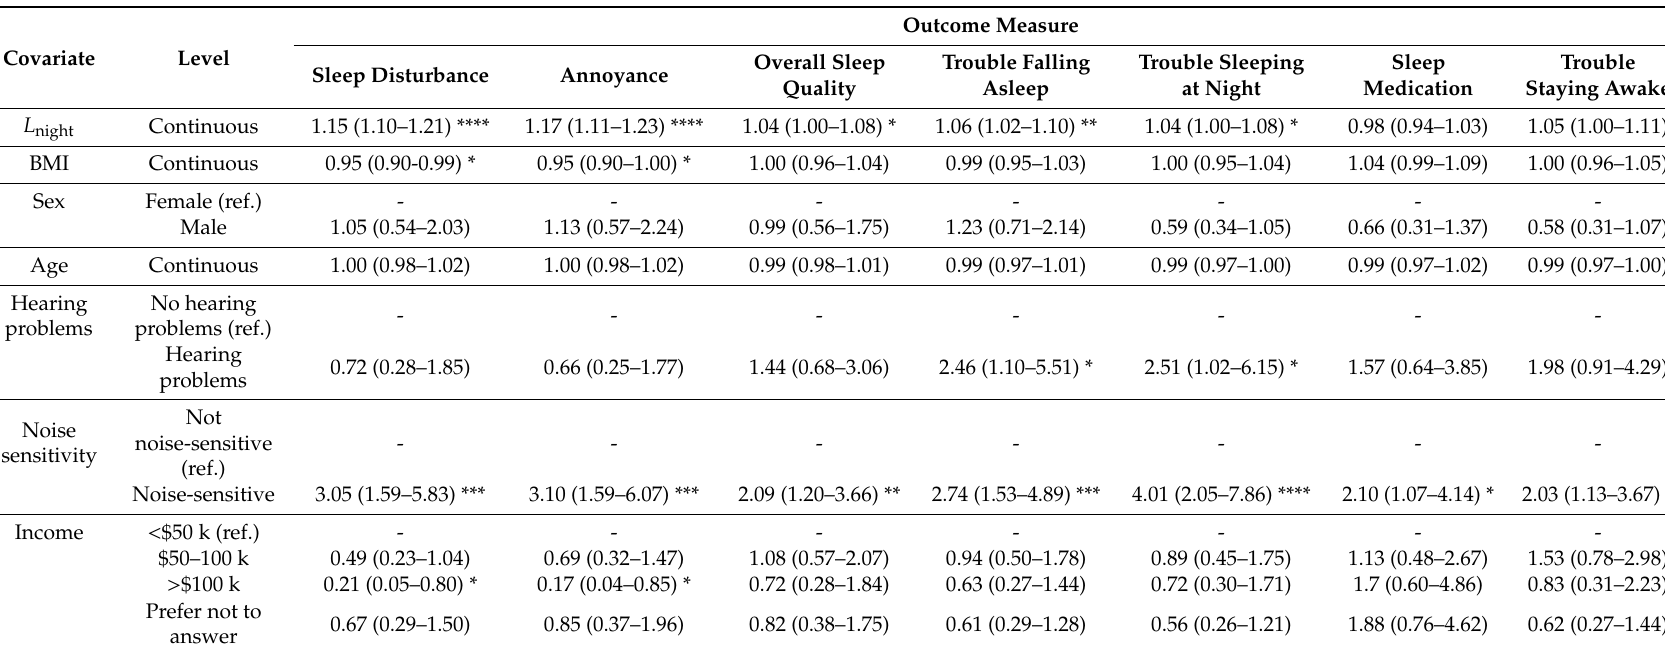
Table 3. Odds ratios (95% confidence intervals) from logistic regression models for sleep quality variables, adjusted for age, body mass index (BMI), sex, hearing problems, noise sensitivity and